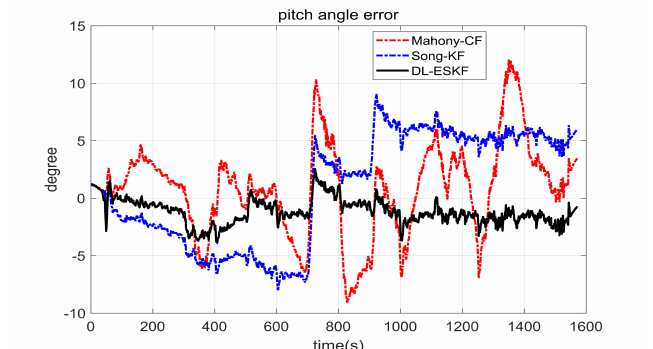
Figure 13. Pitch angle error under dynamic conditions.